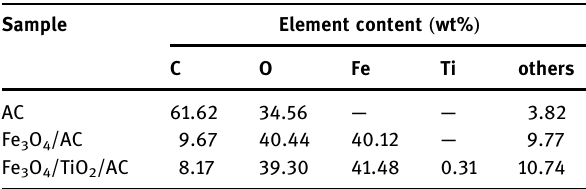
Table 1: Element content on the surface of materials